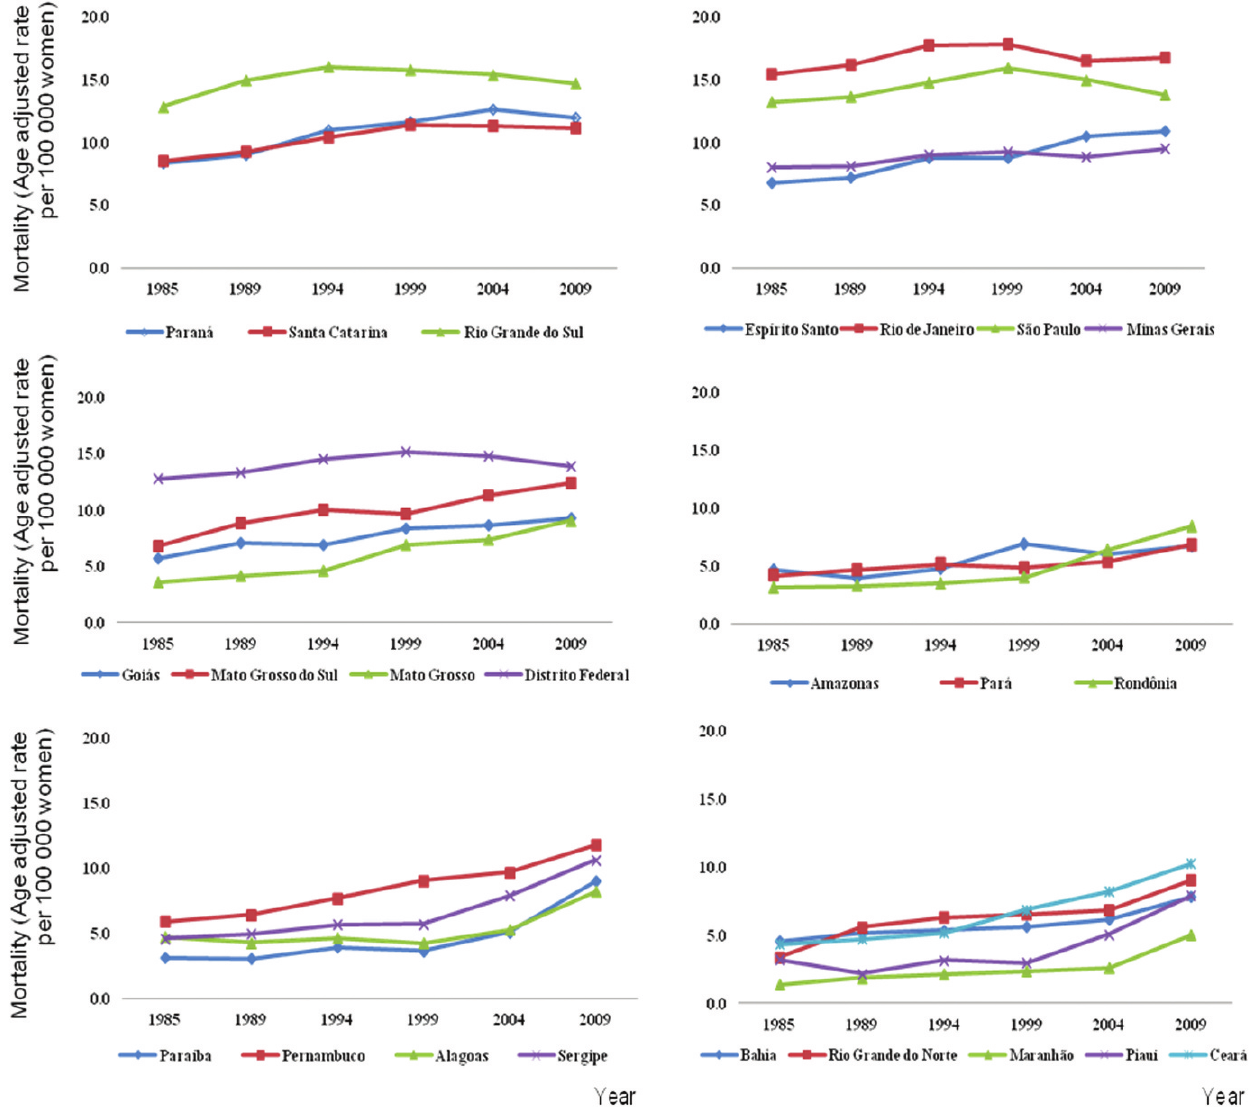
Figure 1 - Female breast cancer mortality rates in the states of Brazil from 1980 to 2009 (5-year average annual mortality rates). The states are grouped in accordance with